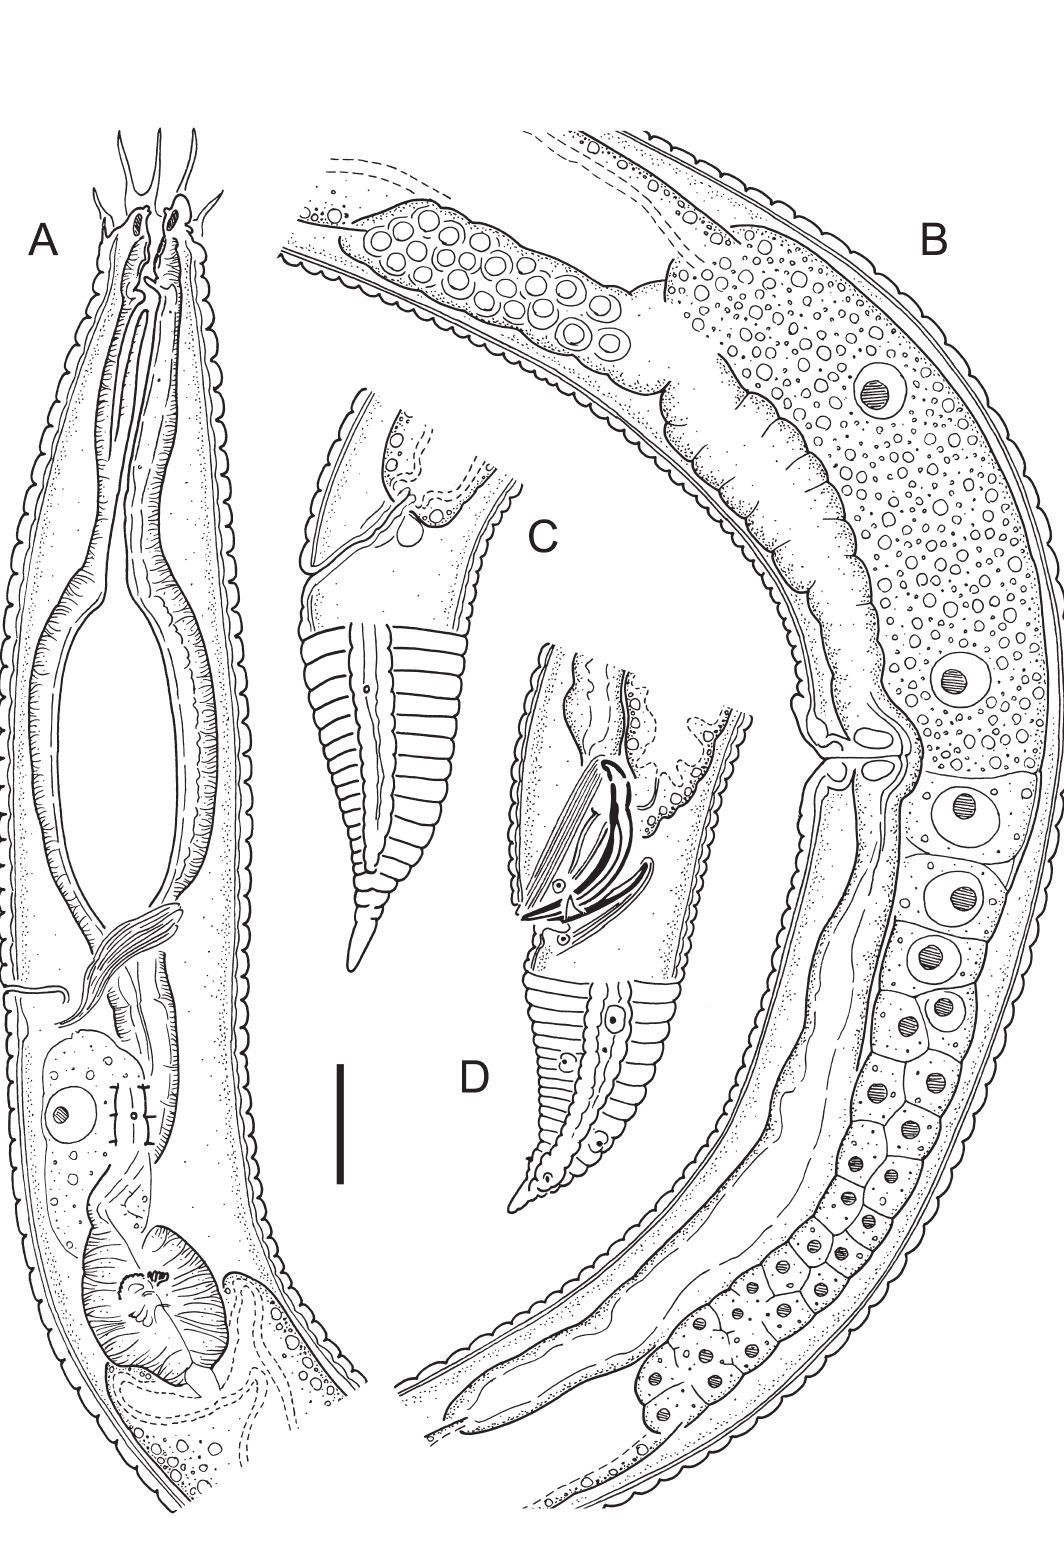
Fig. 1. Paracrobeles kelsodunensis sp. nov. A . Pharyngeal region. B . Female gonad. C . Female tail. D . Male tail. Scale bar = 20